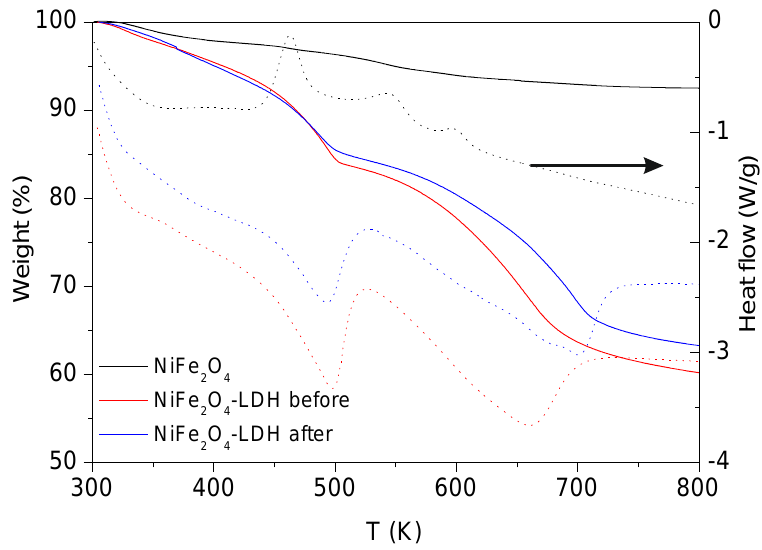
Figure 4. DTA/TGA (Differential Thermal Analysis/Thermogravimetric Analysis) of NiFe 2 O 4 NPs and NiFe 2 O 4 -LDH composite after and before decontamination process.